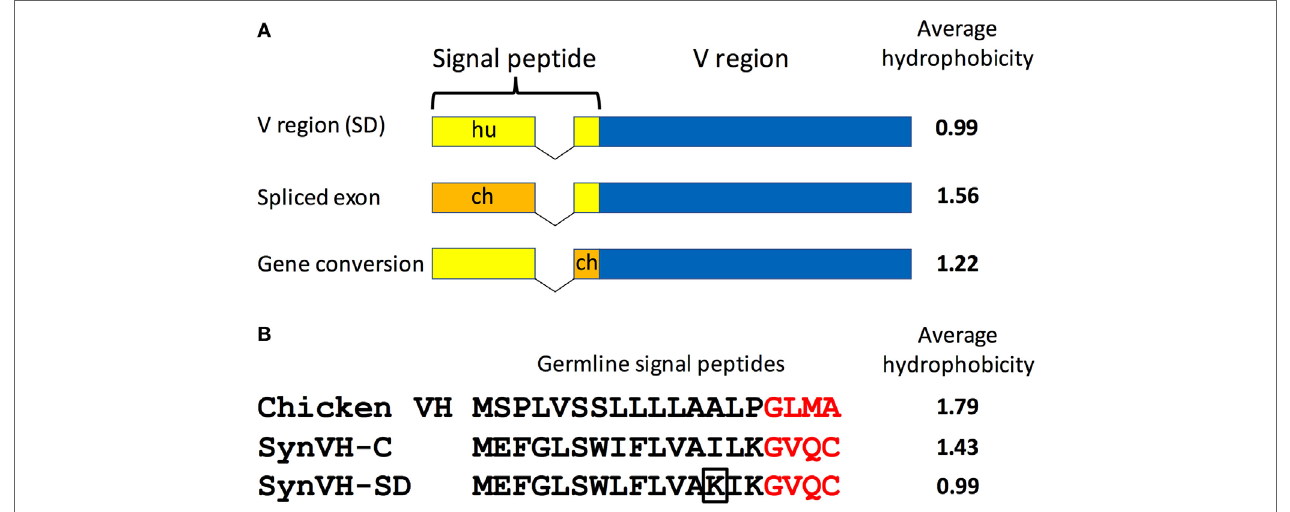
FigUre 2 | The SynVH-SD signal peptide is less hydrophobic than that of SynVH-C and undergoes changes to become more hydrophobic. (a) Diagram of the signal peptide changes observed in OmniChickens. The signal peptide can be changed to chicken sequences either by splicing of the chicken signal peptide exon to the human V region exon or from gene conversion of the portion in the V region exon. Human signal peptide is shown in yellow, chicken in orange. The average hydrophobicity (Kyte–Doolittle, without normalization) is shown for each type of signal peptide. (b) Alignment of the germline signal peptide sequences from the WT chicken VH gene, SynVH-C, and SynVH-SD. The four amino acids encoded in the V region exon are in red. The lysine residue that is often mutated to a hydrophobic residue in SynVH-SD is boxed. The average hydrophobicity is indicated at